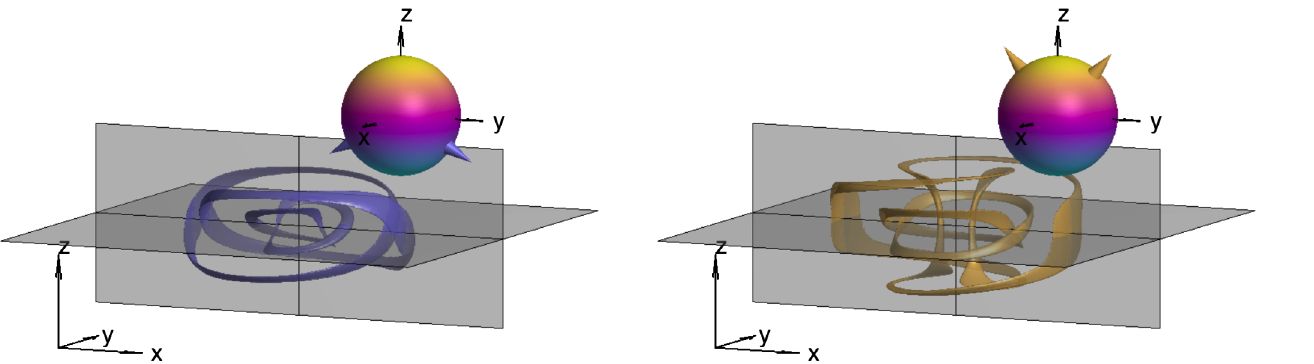
[Figs. 6(h), 6(i), 6(q), 6(r), 7(i), 7(j), 8(i), and 8(j)]